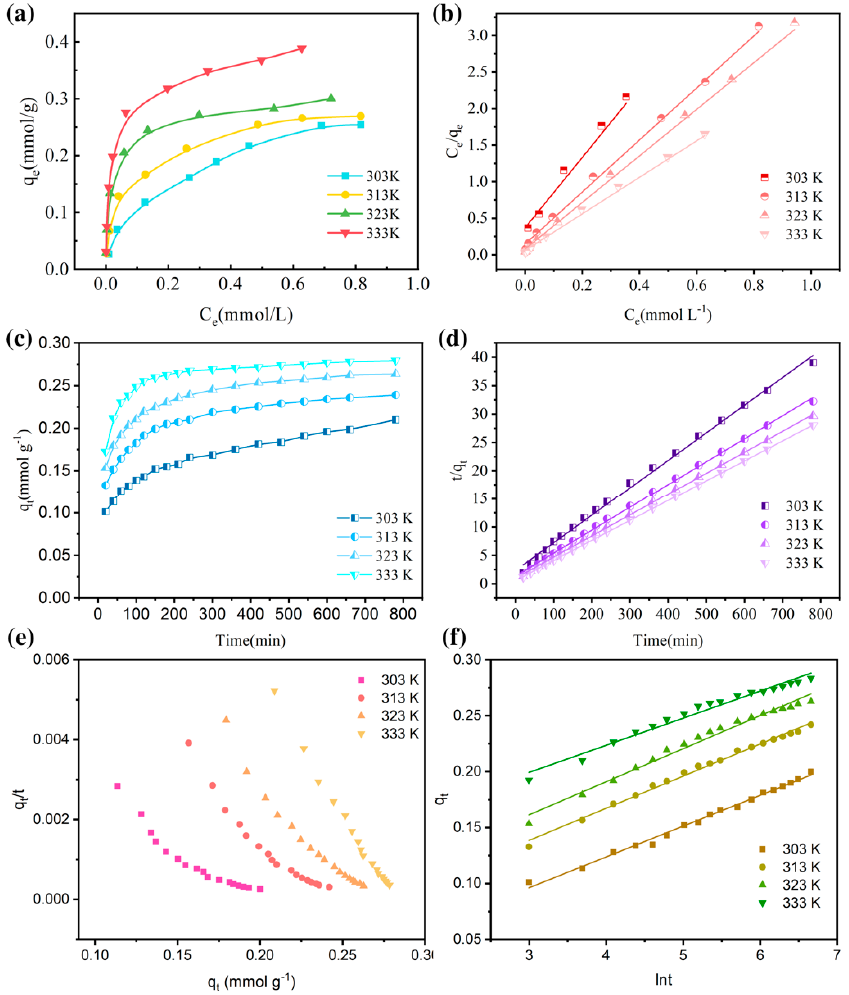
Figure 5. Adsorption isotherms of PA-BWT to UO 22+ : UO 22+ ion concentration 0.1–2 mmol/L, pH 5.0: ( a ) adsorption isotherms and ( b ) regression by the Langmuir equation. Adsorption kinetics of UO 22+ on PA-BWT: UO 22+ concentration 1 mmol/L, pH 5.0: ( c ) adsorption kinetics and ( d ) regression by the pseudo-second-order equation. ( e ) Regression by the pseudo-second-order model (PSO) expressed in a different linearized form. ( f ) Regression by the Elovich model. Table 2. Fitting parameters of the pseudo-first-order and pseudo-second-order models.